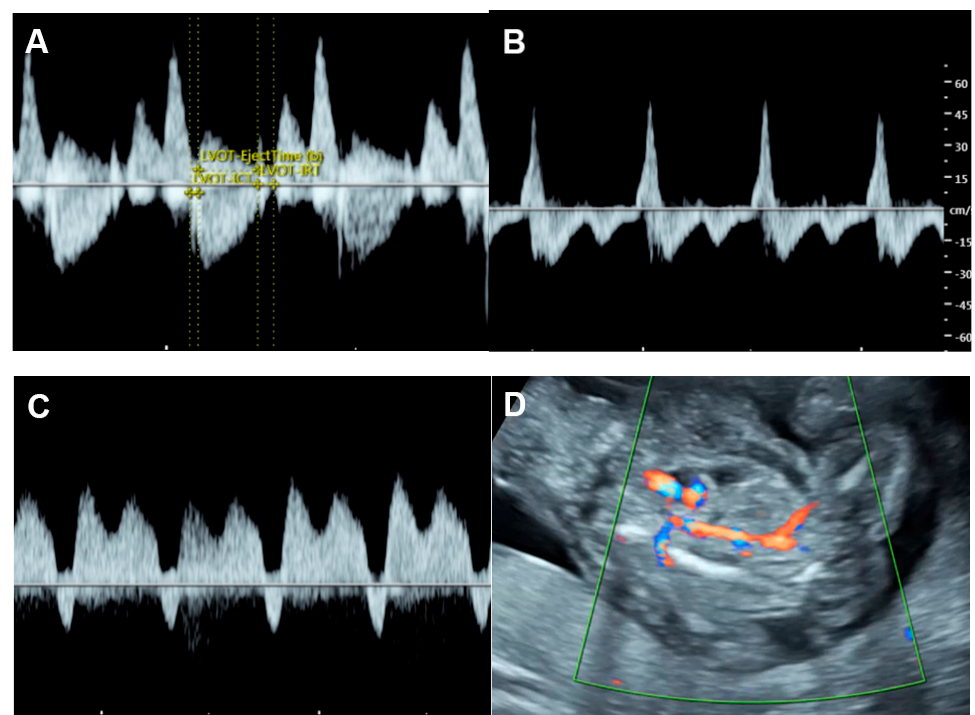
Figure 5. Cardiac dysfunction of the pumping twin in twin reversed arterial perfusion sequence: ( A ) increased Tei index (0.61) with prolonged IRT (46 ms); ( B ) Doppler flow in IVC; markedly re-versed A-wave (45 cm/s); ( C ) reversed A-wave in the ductus venosus; ( D ) acardiac twin with vas-cularization.